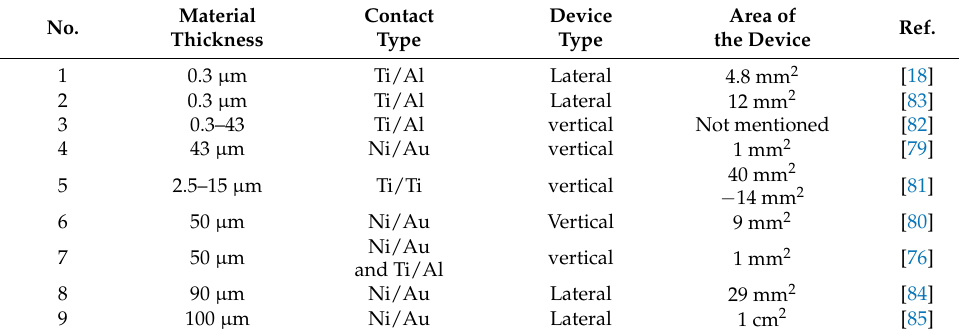
Figure 4. Cross-sectional schematic of lateral and vertical MSM neutron detector [74,82]. Table 5. Device physical parameters.